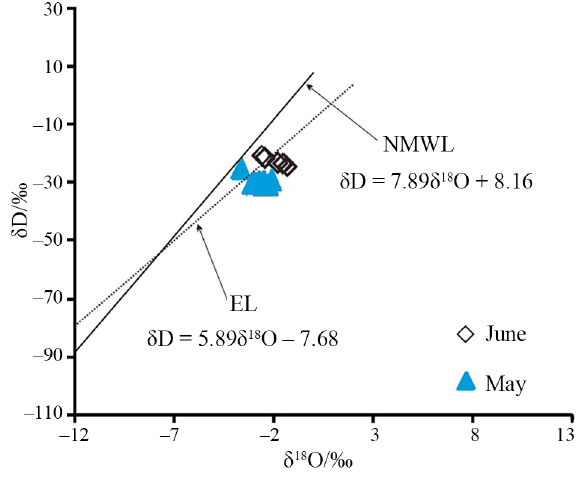
Figure 3. Relationship between lake water δ 18 O and δD